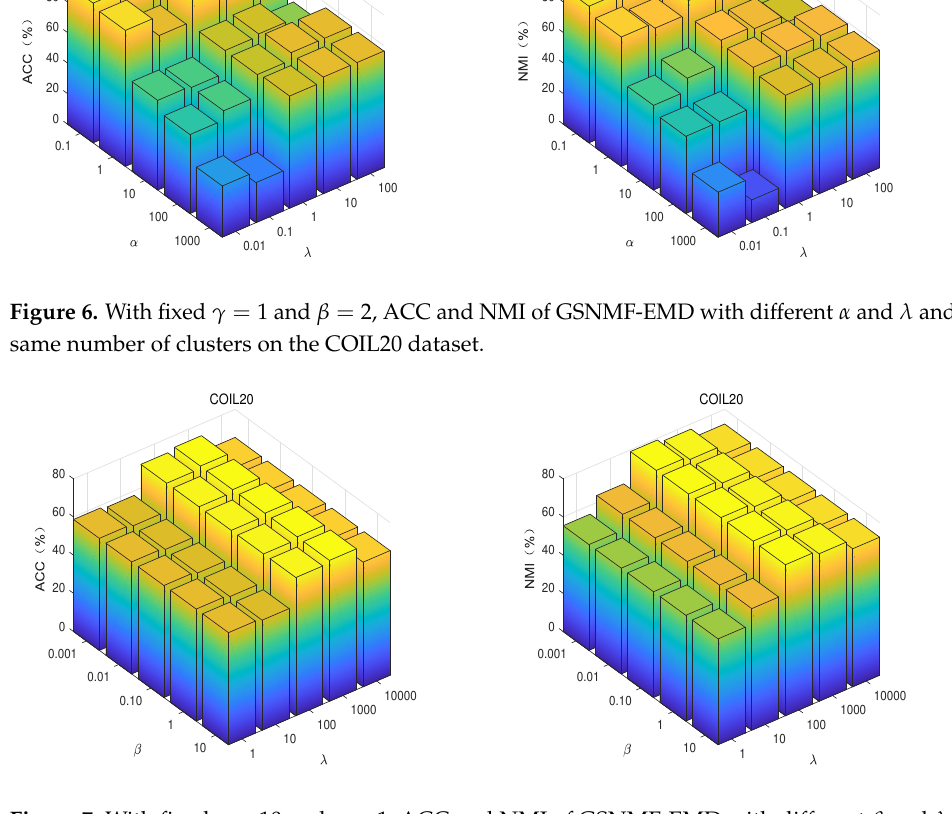
Figure 7. With fixed α = 10 and γ = 1, ACC and NMI of GSNMF-EMD with different β and λ and the same number of clusters on the COIL20 dataset.